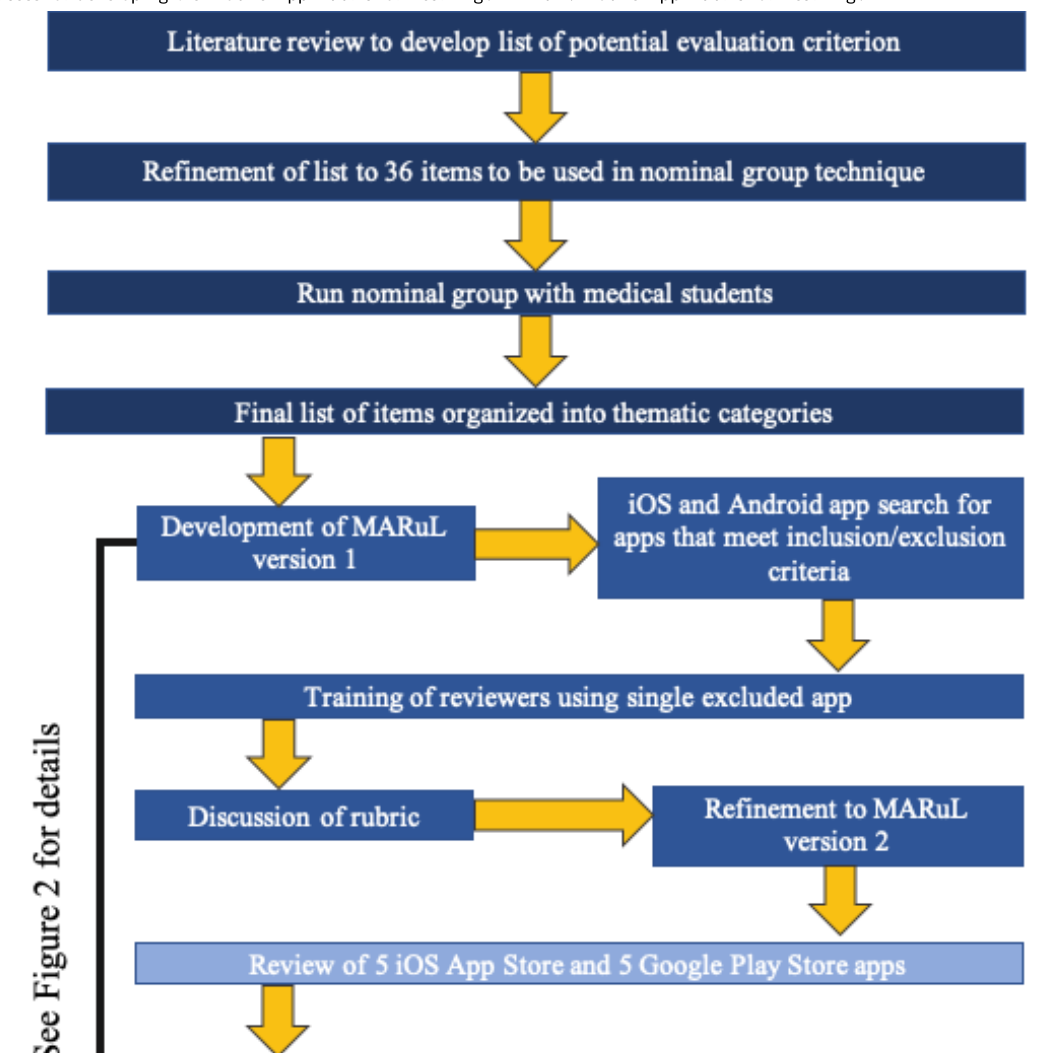
Figure 1. Process for developing the Mobile App Rubric for Learning. MARuL: Mobile App Rubric for